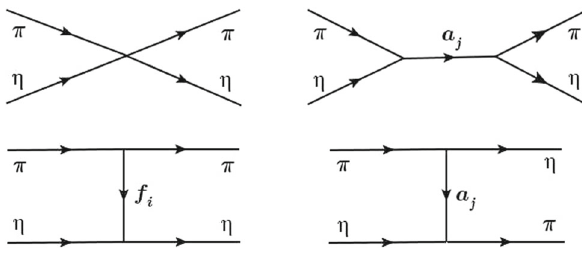
Fig. 1 Tree-level Feynman diagrams representing the πη scattering. The parameters i = 1 ··· n f and j = 1 ··· n a , where n f and n a repre- sent the number of isosinglet and isotriplet scalars respectively, which in the single (double) nonet model are equal to two (four) and one (two)